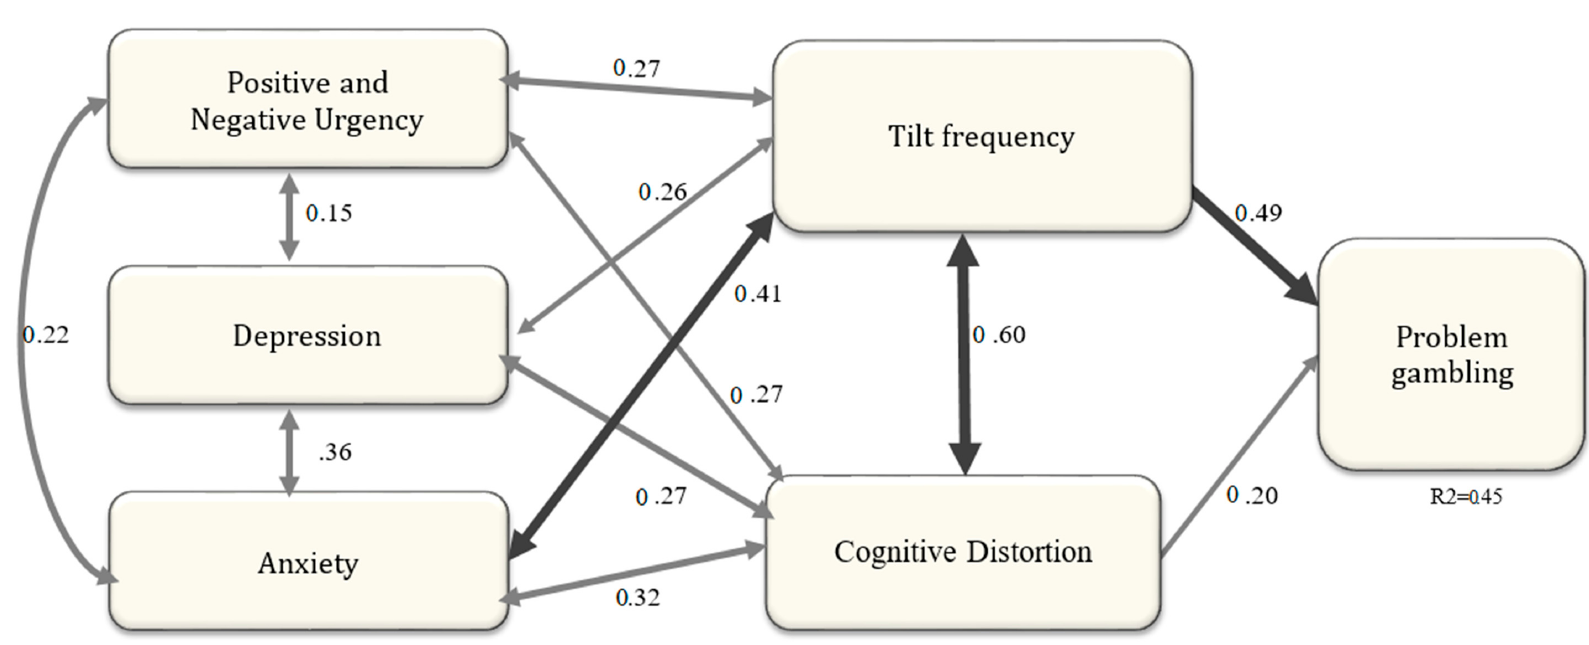
Figure 2. Structural equation model predicting problem gambling in the online poker population (N = 291). For clarity, only the latent variables are shown in the figure.